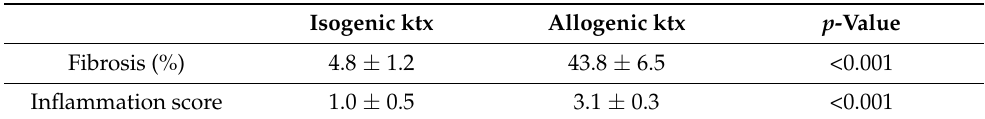
Figure 5. Histological changes in chronic allograft rejection. Representative images of isogenic (left column) and allogenic (right column) kidney grafts 6 weeks after ktx are shown. Histological changes were evaluated on Masson Trichrome stains for fibrosis (MTC, 200-fold magnification, A , B ), fibronectin staining for fibrosis (200-fold magnification, C , D ) and CD3 stains for infiltrating T-lymphocytes (CD3, 200-fold magnification, E , F ). Fibrosis is a hallmark of chronic rejection and is seen in MTC stain in blue and in fibronectin stain in red. MTC stain was accompanied by areas of inflammation ( B , encircled) side-by-side with collagen deposition ( B , arrows) after allogenic ktx. Fibronectin deposition was mainly localized in the renal cortex indicating focal scarring ( D , encircled). In CD3 stain-dense tubulointerstitial infiltrates were seen in allografts mainly containing CD3 positive T-lymphocytes, visualized in red ( E , F ). Tubular autofluorescence in ( C – F ) appears green and was almost lost in allogenic kidney grafts indicating severe tubular destruction. Table 3. Semiquantitative analysis of allogenic renal